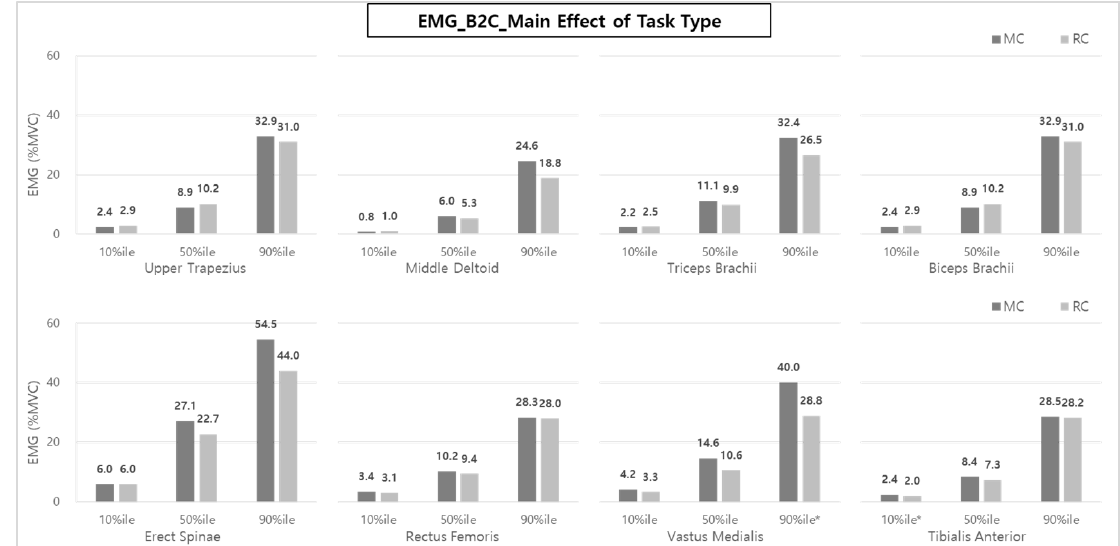
Figure 6. The effect of task type on each muscle activity during B2C. Asterisk (*) indicates that the difference between means is statistically significant at p < 0.05.